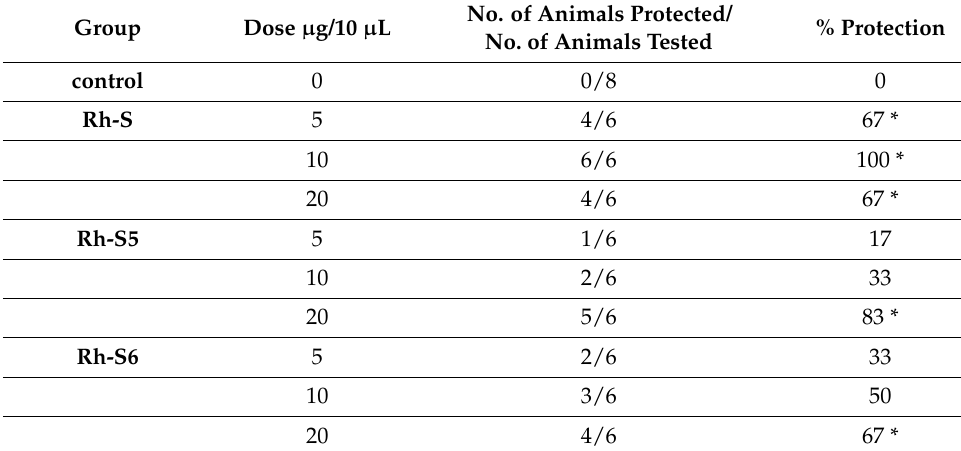
Table 5. The activity of Rh-S, Rh-S5, and Rh-S6 in the 6 Hz test in